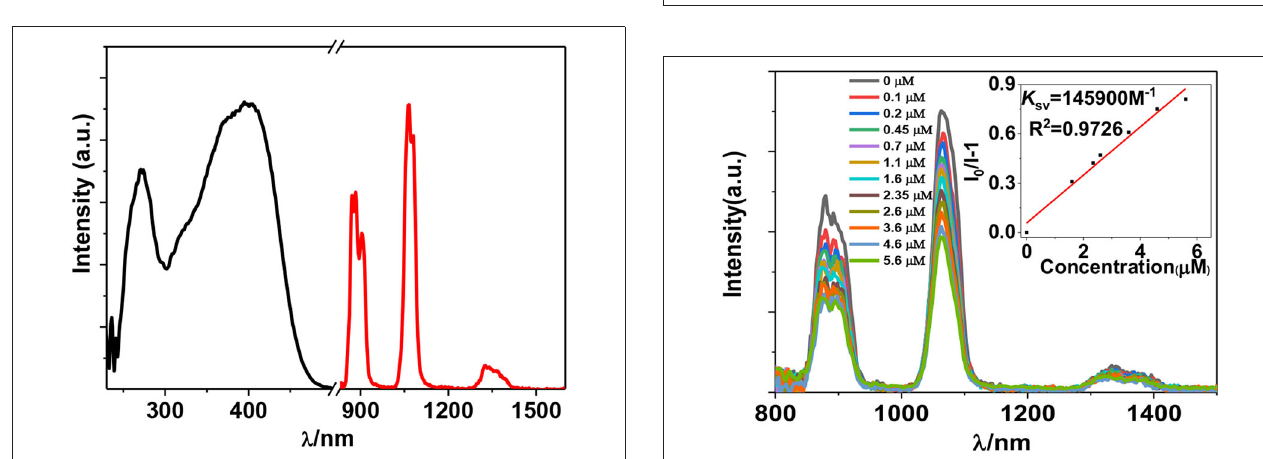
FIGURE 5 | Lanthanide luminescent response of 1 (5 µ M) to TNP in CH 3 CN ( λ ex =